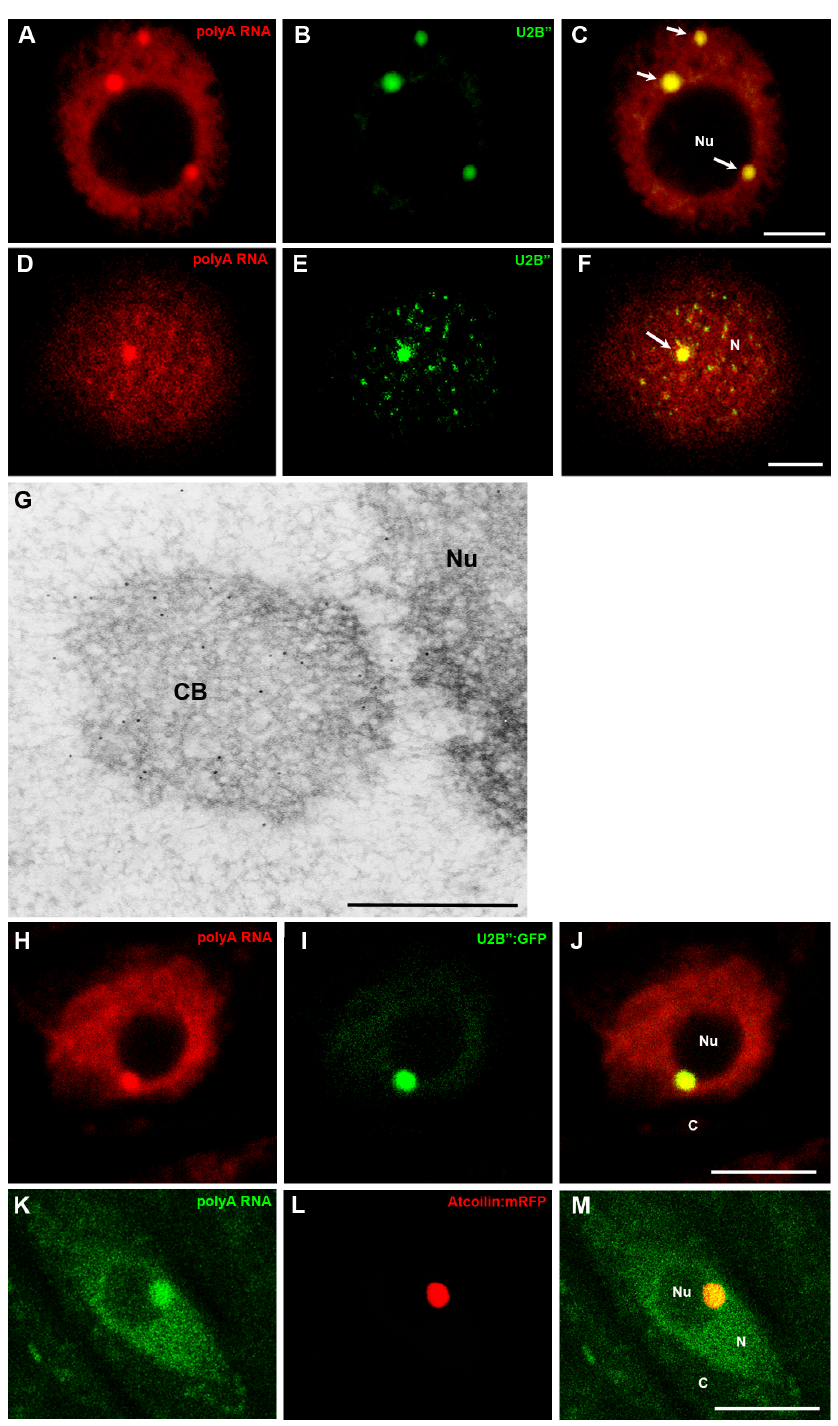
Figure 3. Double labelling of poly(A) RNA and the U2B’’ protein in Lupinus (A–C) and Allium (D–F) root cells. Poly(A) RNA present within Cajal bodies stained an anti-U2B’’ antibody (arrows). Immunogold labelling of poly(A) RNA in the Cajal bodies (CBs) of Lupinus root cells. Gold particles were mainly observed in the Cajal body (CB) (G). Simultaneous localisation of U2B’’:GFP and poly(A) RNA in transgenic Arabidopsis thaliana root cells. Strong colocalisation in Cajal bodies (H–J). Localisation of poly(A) RNA with Atcoilin:RFP in Arabidopsis thaliana root cells. Accumulation of poly(A) in Cajal bodies (K–M). Bar, 5 m m. N-nucleus, Nu- nucleolus, C- cytoplasm.